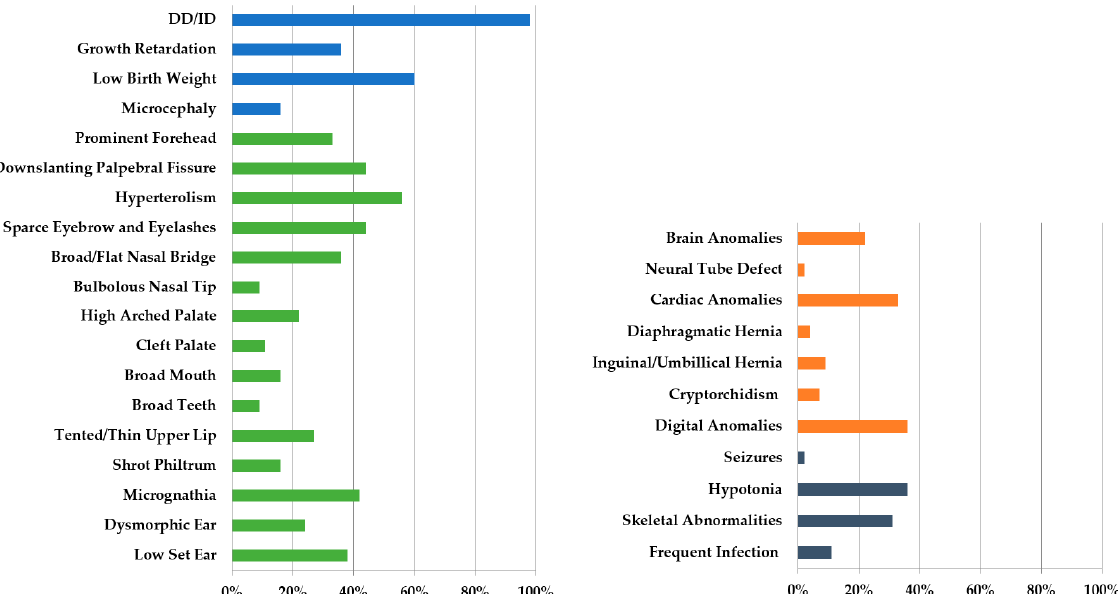
Figure 4. Literature review of the clinical features and frequencies of 14q duplication in 45 reported cases attributed to translocation, tandem duplication, inversion, or insertion [5–49]. Blue bar, detailed phenotypes of growth and development; green bar, detailed phenotypes of facial dysmorphisms; orange bar, detailed phenotypes of other organ system anomalies; grey bar, detailed phenotypes of other problems; DD, developmental delay; ID, intellectual disability.